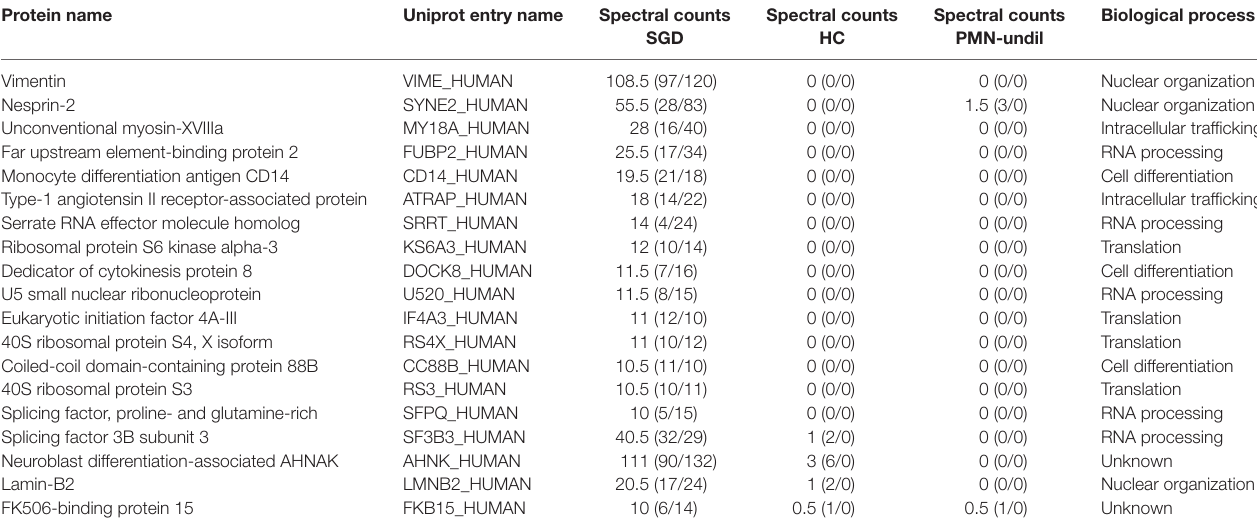
The identified proteins are listed according to decreasing spectral count ratio (ND/SGD). Spectral counts for each duplicate are indicated in brackets.